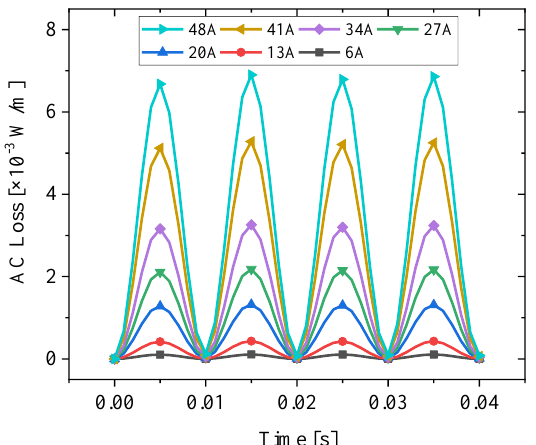
Figure 9. The AC loss of superconducting tapes under different currents.